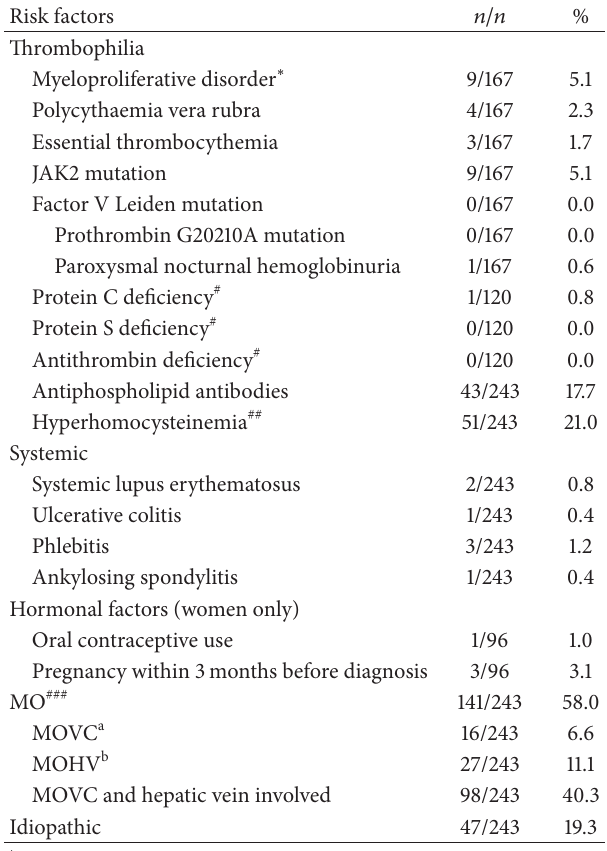
Table 2: Risk factors present in 243 patients with Budd-Chiari syndrome (patients could have more than one factor